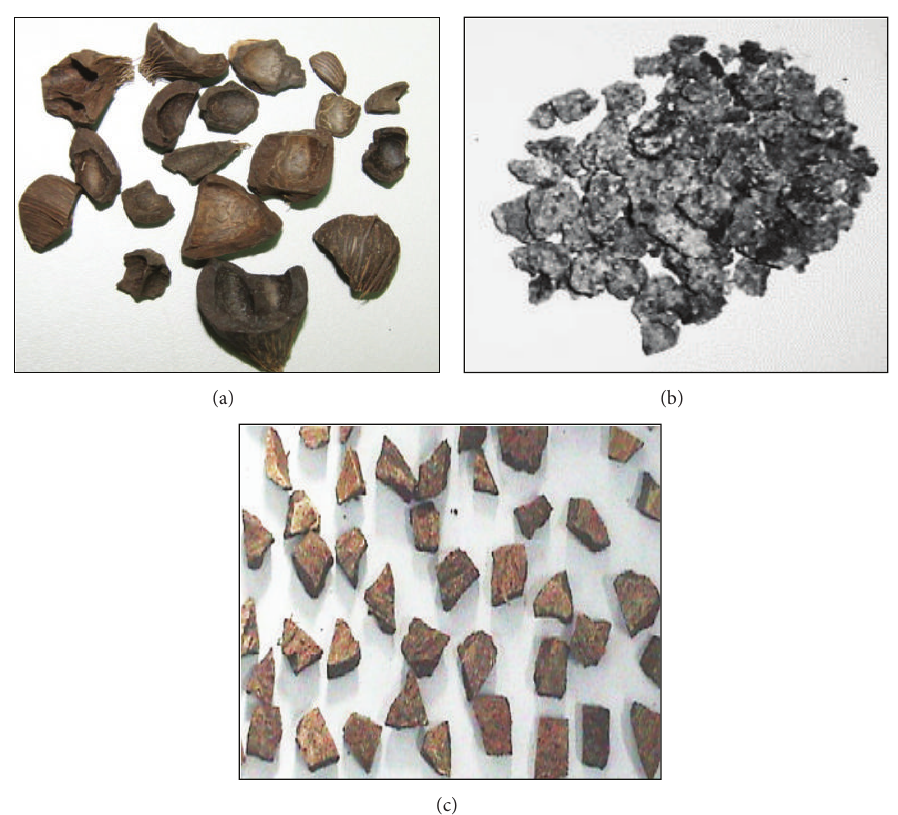
Figure 1: (a) Oil palm shell [10], (b) palm oil clinker [14], and (c) coconut shell [15] as lightweight